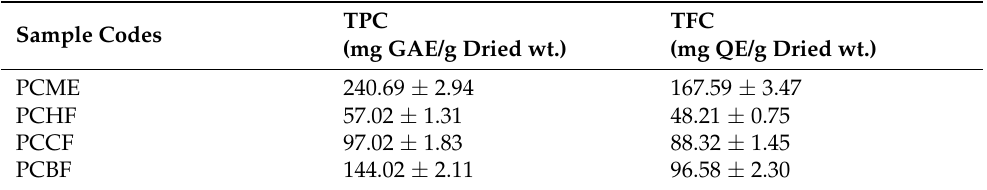
Table 1. Total phenolic and total flavonoid contents (TPC and TFC) of P. candollei (sample conc. 1 mg/mL). Sample